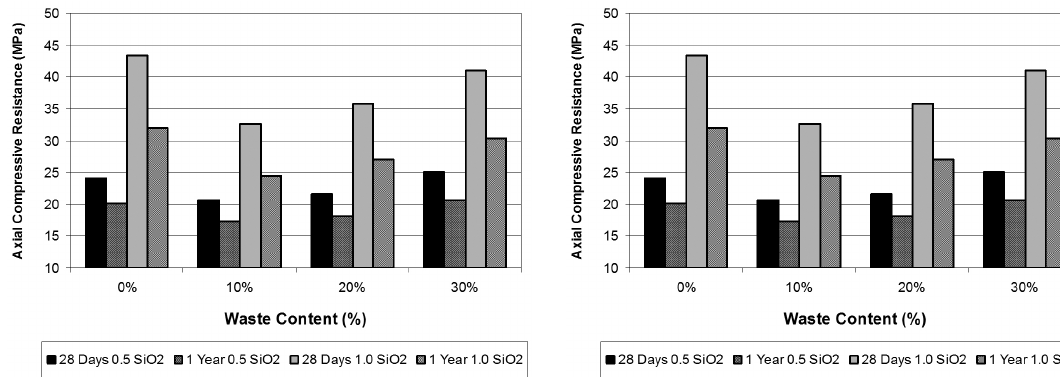
Figure 5. Changes in the appearance of magnesium phosphate cement matrices after being subjected to accelerated aging by ultraviolet (UV) radiation.